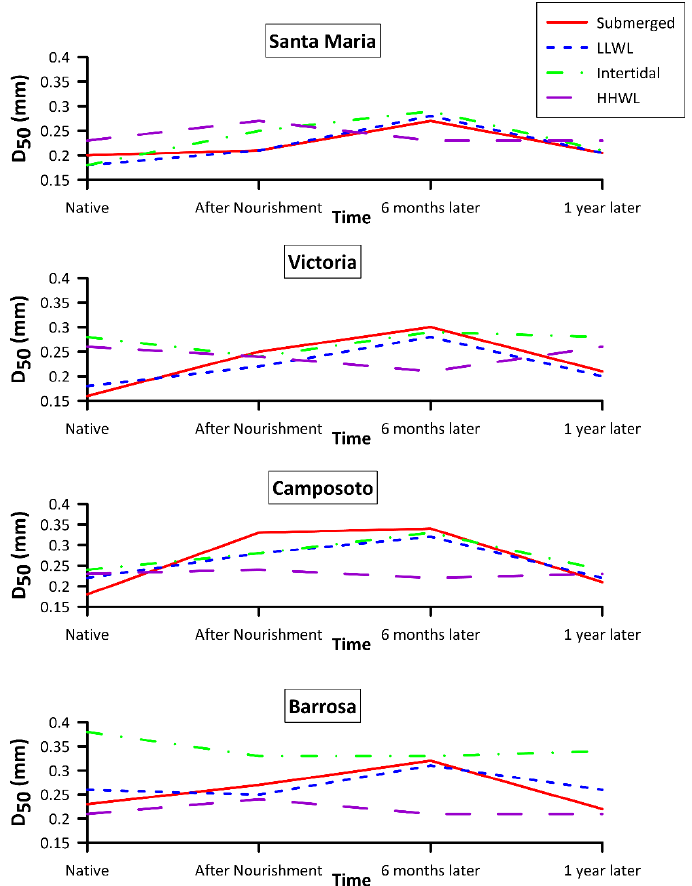
Figure 6. Results of D 50 (in mm) obtained at the four beaches (Santa Maria del Mar, Victoria, Camposoto, and Barrosa) during one year of monitoring. Table 3. Total variation of D 50 (between native sand and nourished sand after one year) at SMM, VB, CB, and BB at the different levels of the profile (Submerged, LLWL, Intertidal, and HHWL). Total Variation in mm and Dif% of D 50 in Each Zone Beach